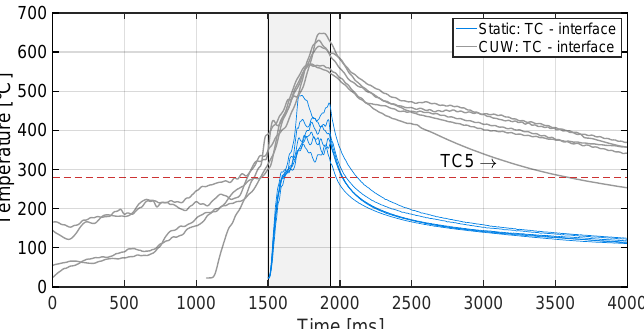
Figure 13. Combined interface temperature evolutions of continuous (reference case) (Figure 6a) and static (Figure 9a) processes superimposed for time that thermocouple experiences vibrations directly under sonotrode. The red dashed line indicates the melting temperature of PPS as experimentally determined by DSC